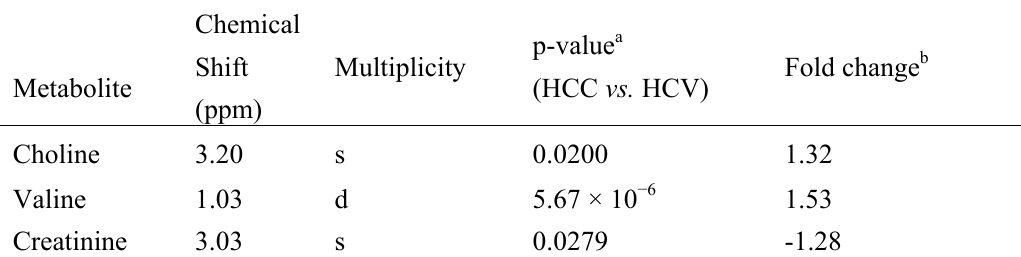
Table 2. Summary of three metabolites having low